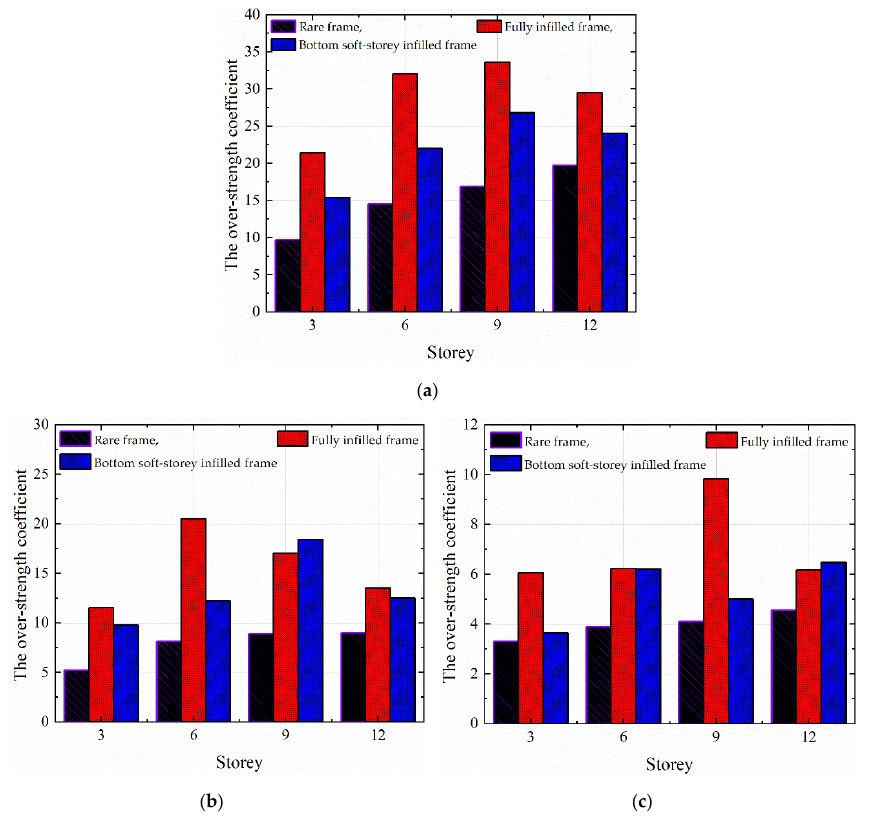
Figure 10. Over-strength coefficient values for different precautionary intensities: ( a ) intensity Ⅵ ; ( b ) intensity Ⅶ ; ( c ) intensity Ⅷ .